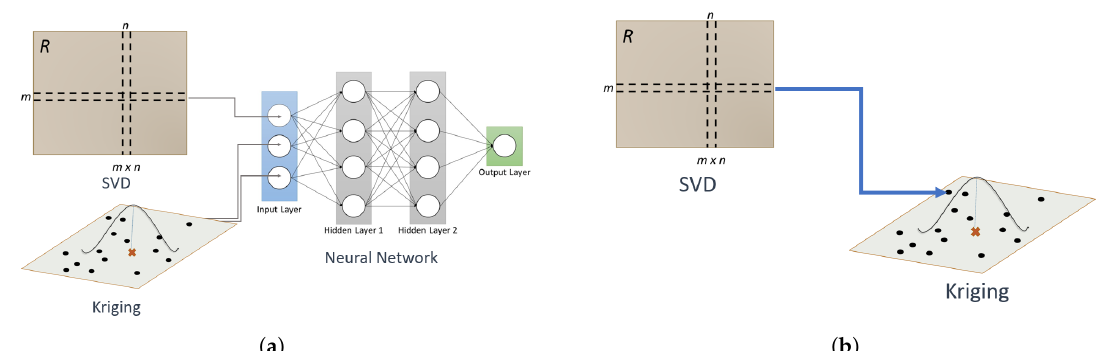
Figure 1. Combination of SVD and Kriging. ( a ) Combination of Individual Results [18]; ( b ) Feeding SVD Results into